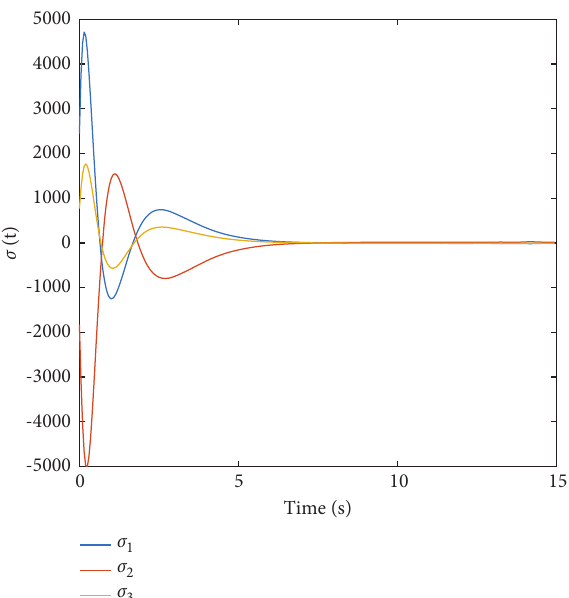
Figure 3: Designed sliding mode surface.